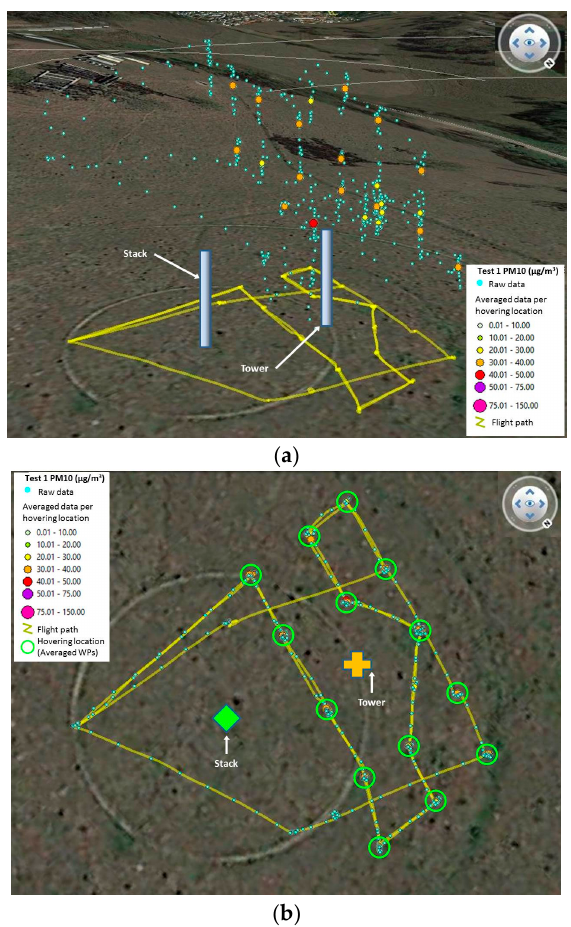
Figure 18. Field data collected for Test 1 with the airborne module before and after processing, ( a ) 3D view, and ( b ) top view with averaged locations indicated (repeated per height programmed).